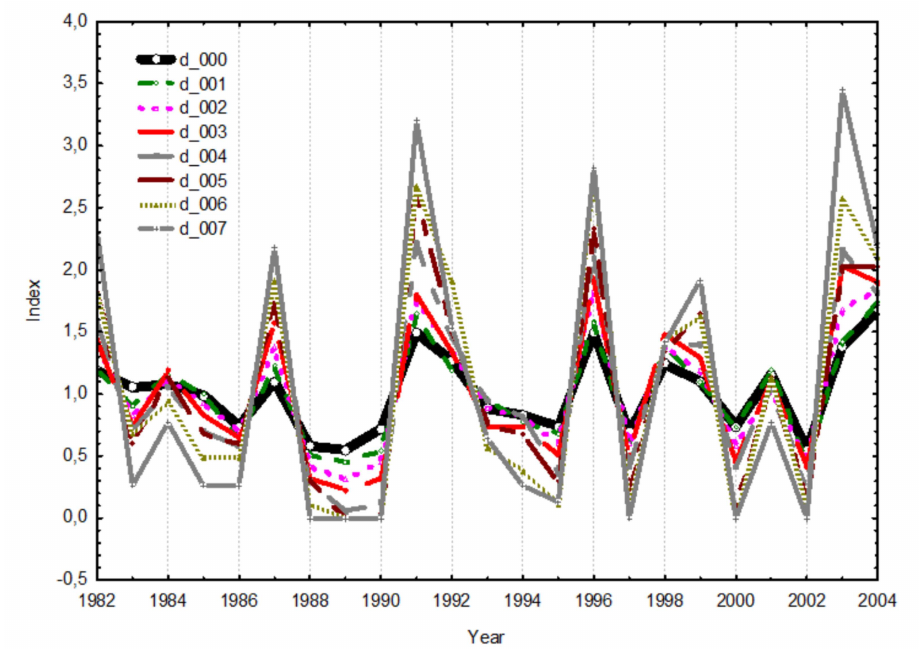
Fig. 5. Simulated tree-ring growth chronologies by different values of drainage